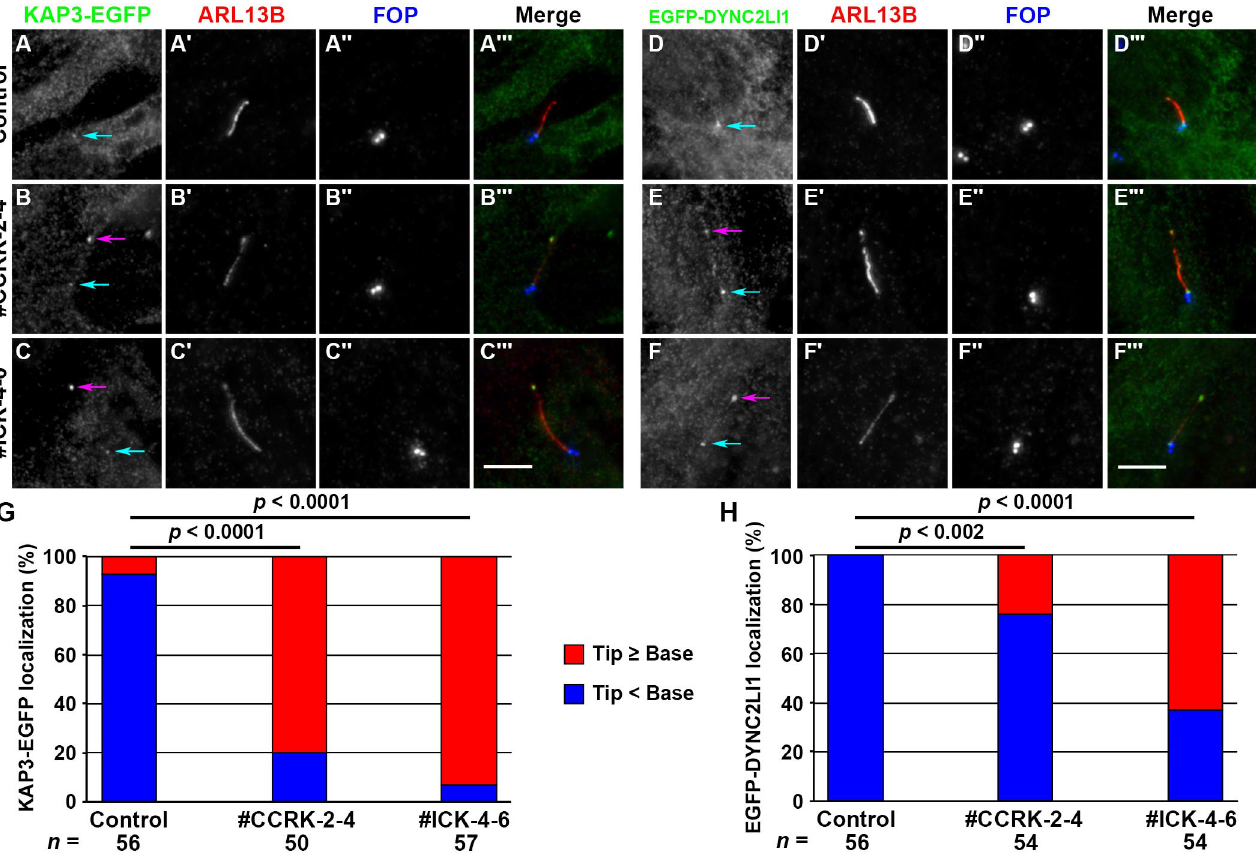
Fig 3. Accumulation of kinesin-II and dynein-2 at the ciliary tips of CCRK -KO cells. Control RPE1 cells (A, D), the CCRK -KO cell line #CCRK-2-4 (B, E), and the ICK -KO cell line #ICK-4-6 (C, F) stably expressing KAP3-EGFP (A–C) or EGFP-DYNC2LI1 (D–F), were serum-starved for 24 h, and triple immunostained for GFP, ARL13B, and FOP. Cyan and magenta arrows indicate the positions of KAP3-EGFP and EGFP-DYNC2LI1 signals at the ciliary base and tip, respectively. Scale bars, 5 μ m. (G, H) The localization of KAP3-EGFP (G) and EGFP-DYNC2LI1 (H) in individual cells was classified as ‘mainly ciliary tip (Tip � Base)’ and ‘mainly ciliary base (Tip < Base)’, and the number of cells in each category was counted. The percentages of these categories are expressed as stacked bar graphs. Statistical significances were calculated using one-way ANOVA followed by the Dunnett’s multiple comparison test. Note that, owing to the relatively high cytoplasmic background staining for KAP3-EGFP and EGFP-DYNC2LI1, we could not precisely estimate the staining intensities.